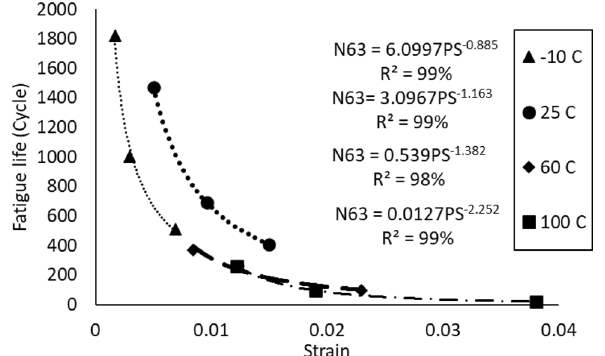
Figure 16. The Coffin Manson equation at different testing temperatures.